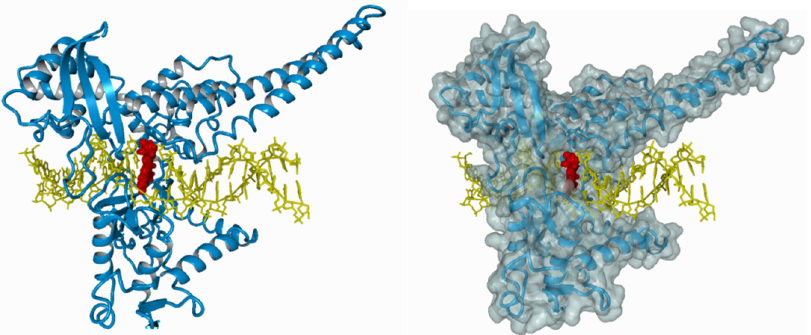
Figure 3. The ternary irinotecan–topoisomerase I–nicked DNA complex. Inhibition of topoisomerase I (blue) bound to the DNA molecule (yellow) with CPT ‐ 11 (red).